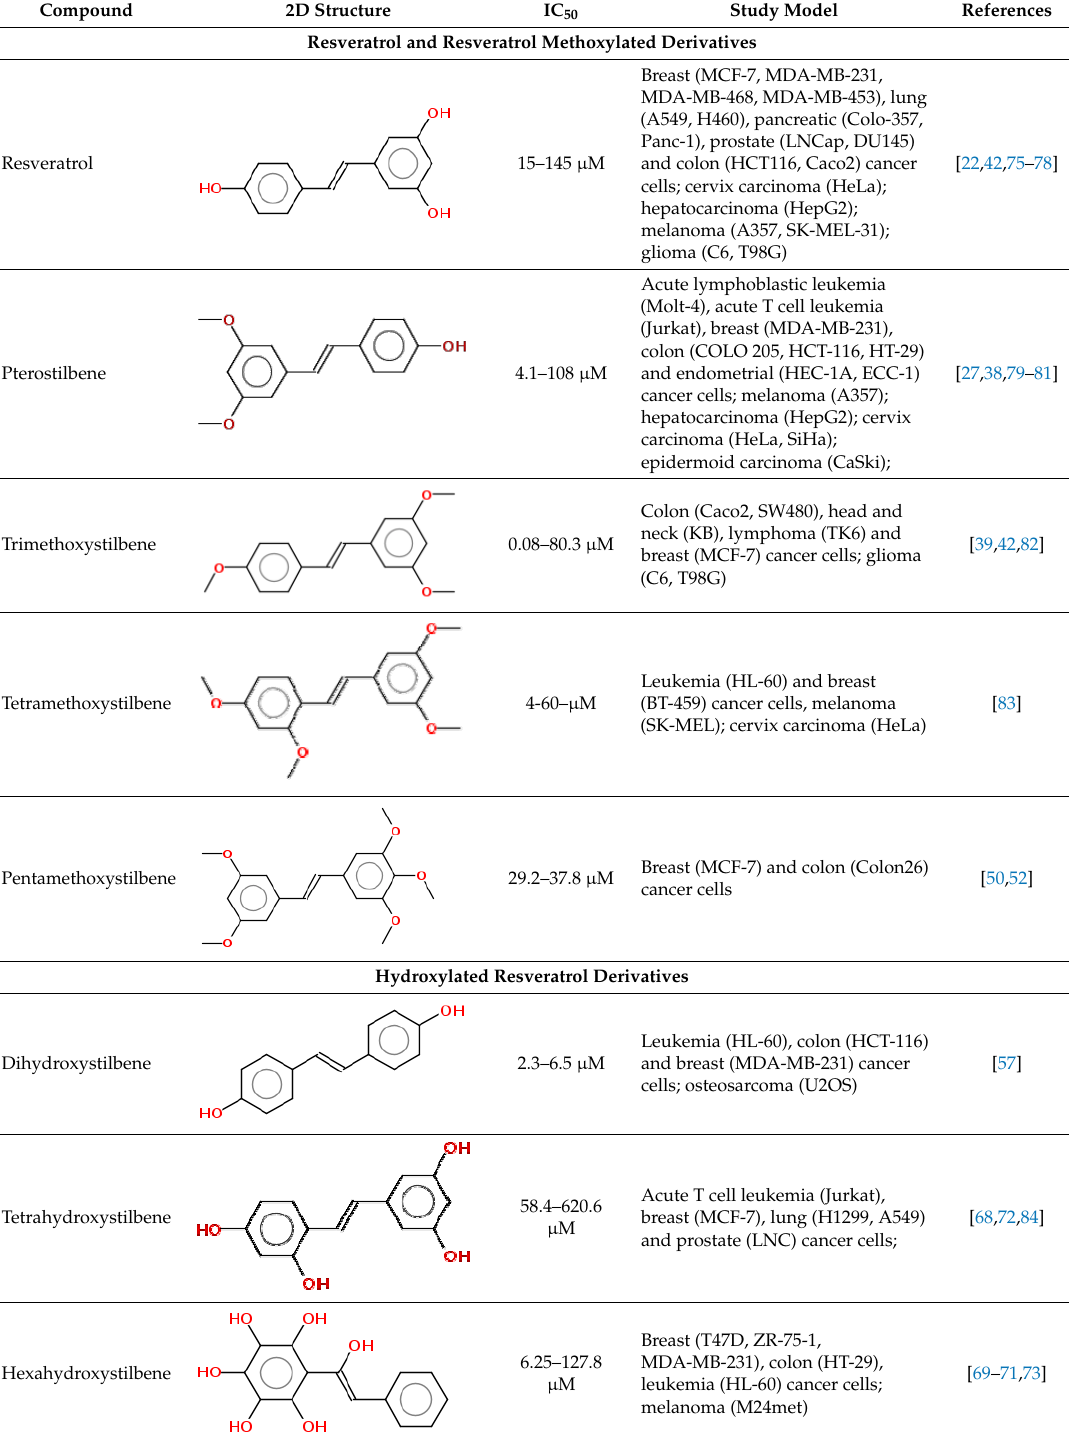
Table 1. IC 50 values of resveratrol and derivatives in different study models.